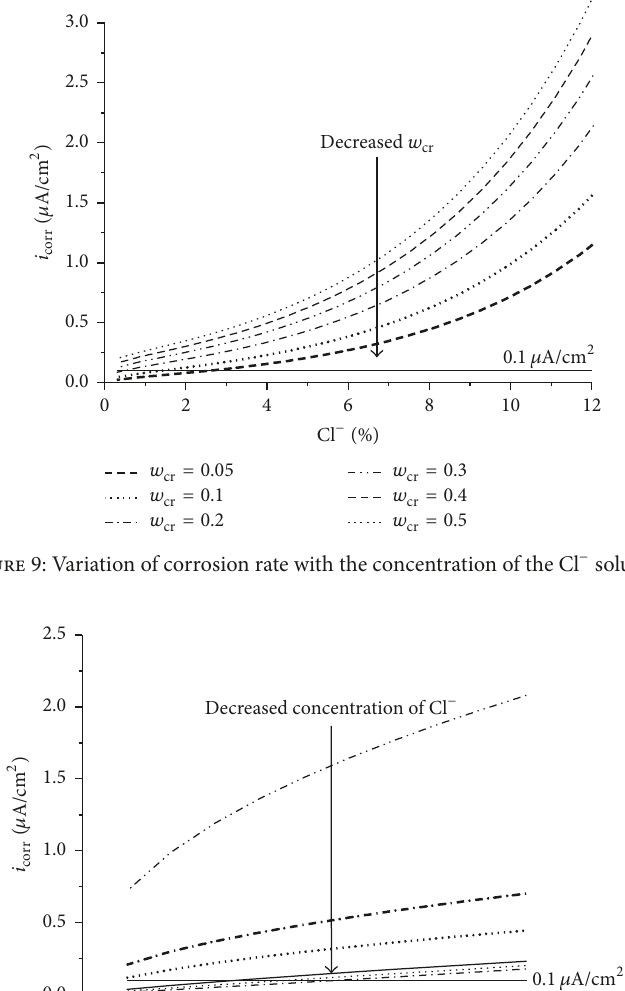
Figure 10: Variation of corrosion rate with crack